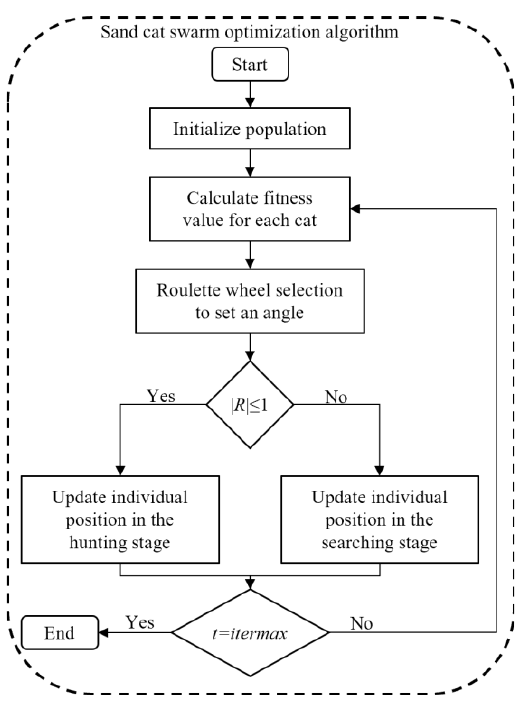
Figure 2. The flowchart of the sand cat swarm optimization